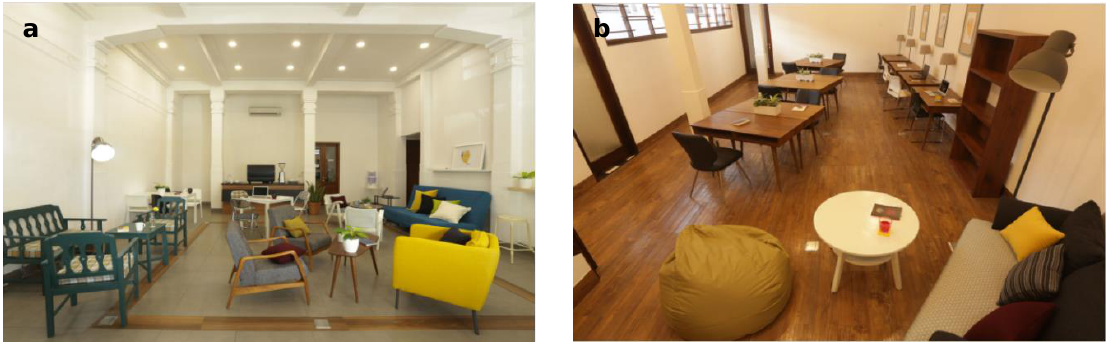
Fig. 2 ke:kini co-working space; a 1 st Floor, b 2 nd Floor (ke:kini, 2017)